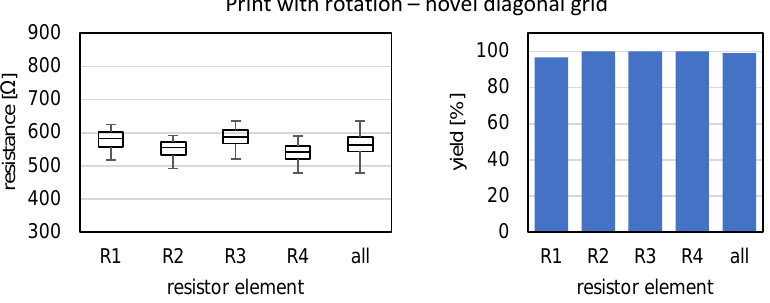
Figure 12. Electrical properties of SG full bridges, novel print with rotation using diagonal grids. Left : Resistances of the resistance elements; Right : Yield of intact resistance elements.